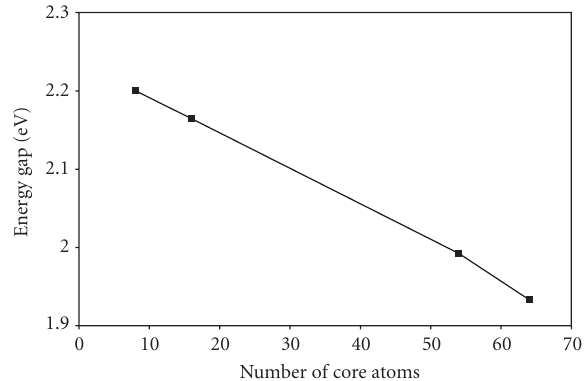
Figure 7: Energy gap variation as a function of number of core atoms in LUC-DFT method for GaAs nanocrystals.